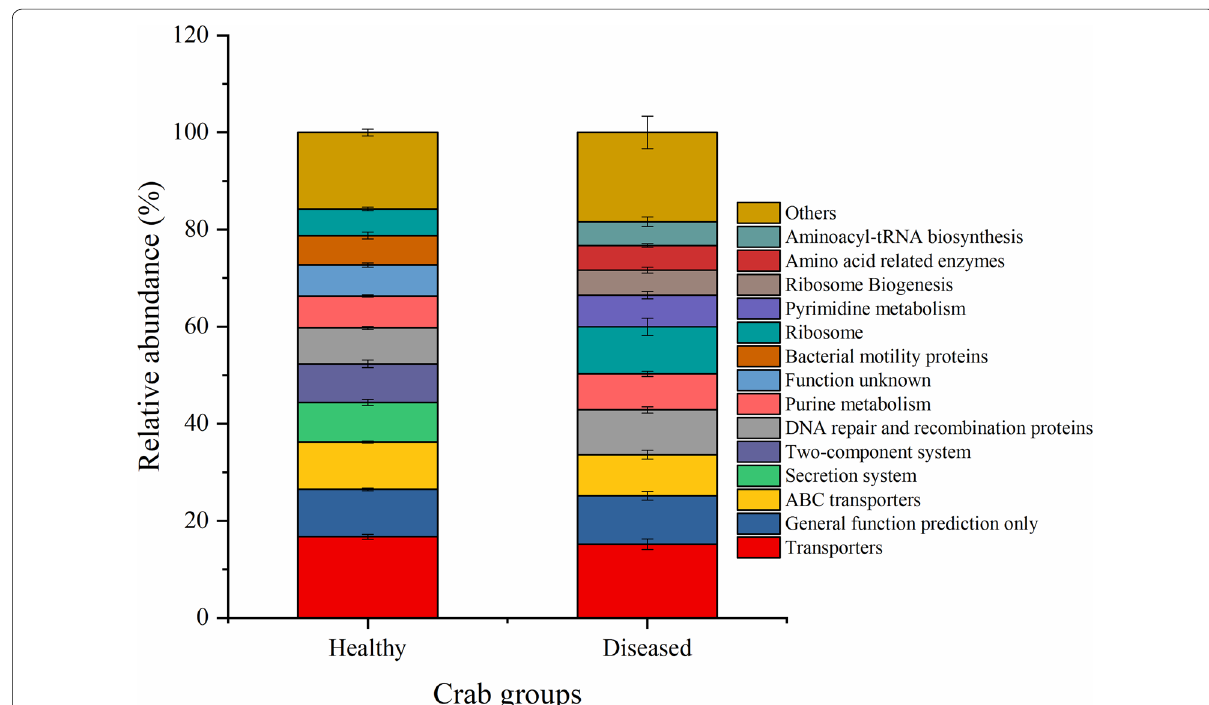
Fig. 4 Microbial functions of the top 10 most abundant KEGG level 3 categories averaged over each crab group. Values show means and 1 standard error of mean (mean